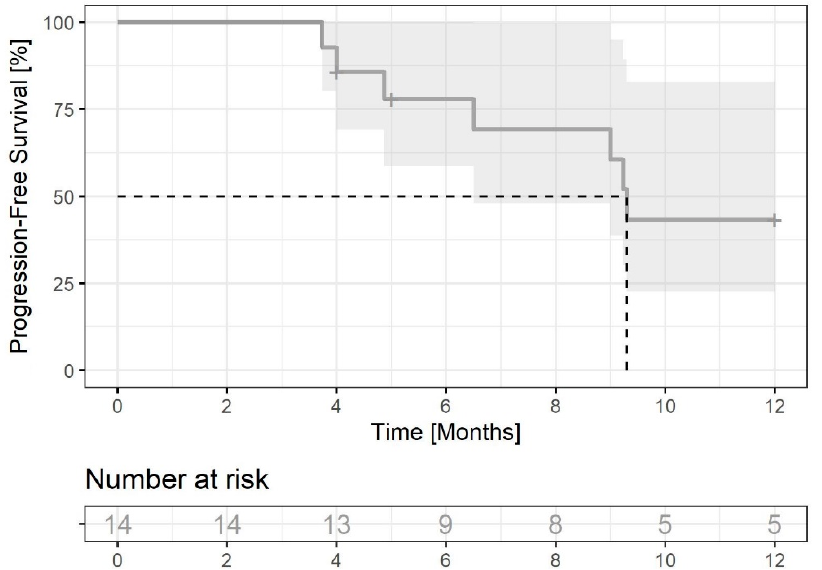
Figure 3. PFS of patients with brain metastases (n = 14) (excluding those with bone and meningeal metastases only). The dashed line indicates median PFS, grey field indicates 95% CI.